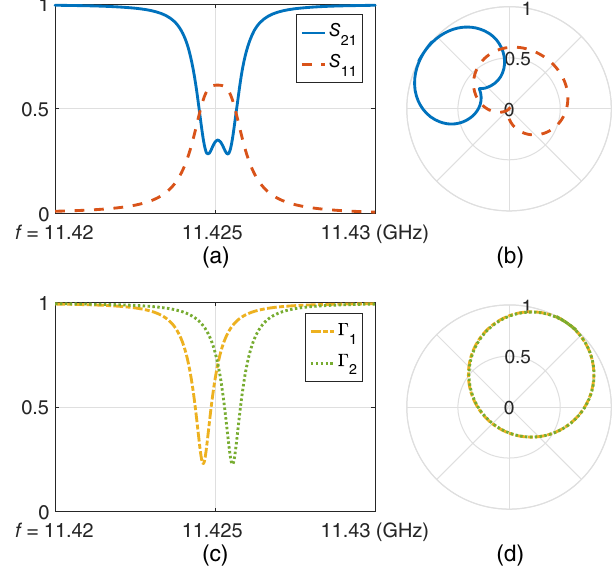
FIG. 21. Simulation of a pulse compressor with an elliptical cavity and reconstruction of reflection spectrum for each polar- ized mode. (a) Simulated transmission and reflection spectra of a pulse compressor with the elliptical cavity. (b) Polar plot of (a). (c) Reconstructed reflection spectra of two eigenmodes in the elliptical cavity. (d) Polar plot of